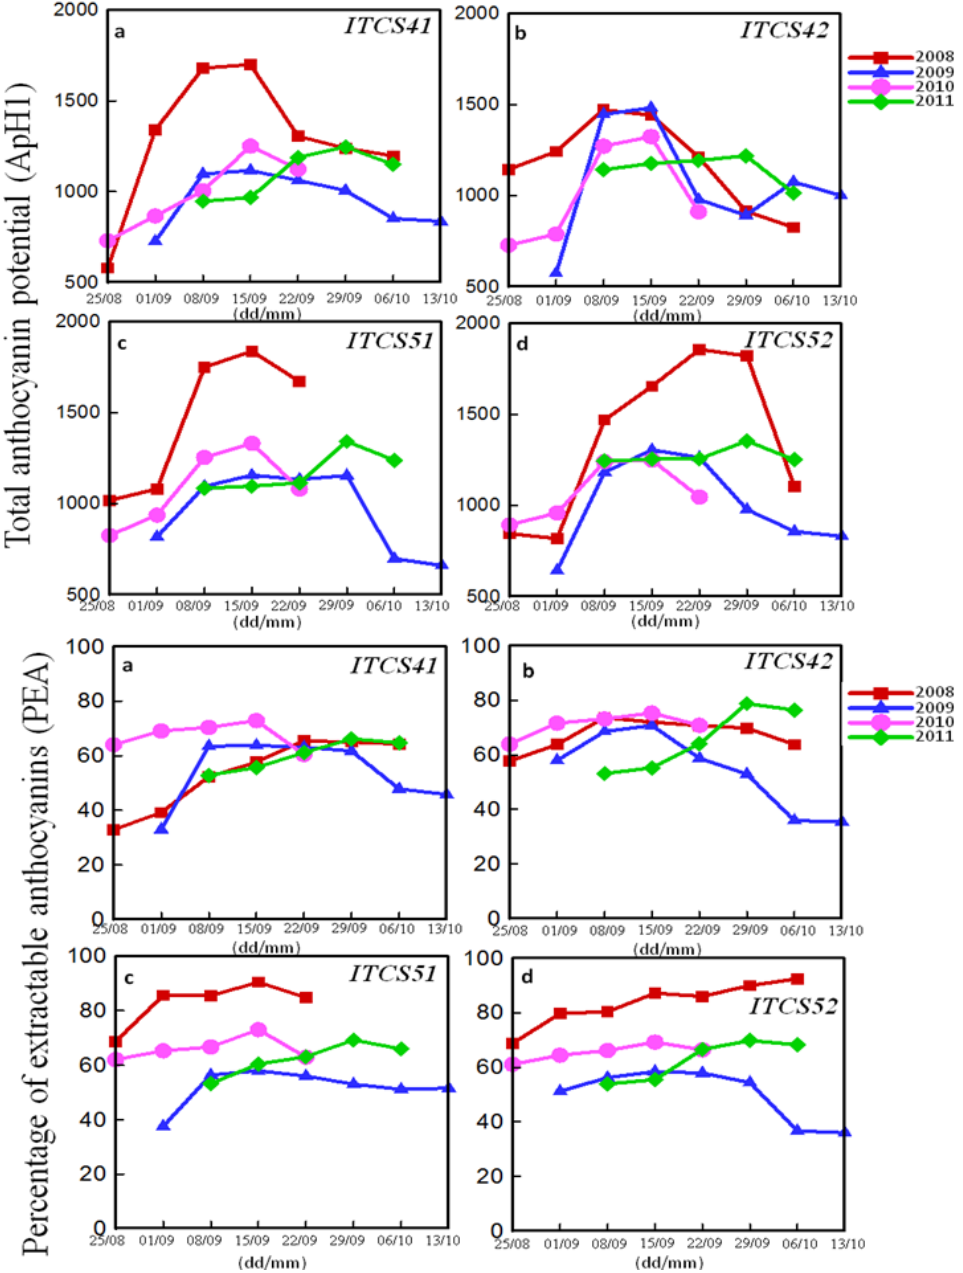
Figure 2. Total anthocyanin potential (AntpH1) and percentage of extractable anthocyanin (PEA) (calculated by Glories method) of four plots ITCS41 ( a ); ITCS42 ( b ); ITCS51 ( c ); and ITCS52 ( d ) of Cabernet Sauvignon grapes as a function of time (day (dd)/month (mm)) over four years (2008, 2009, 2010, and 2011).